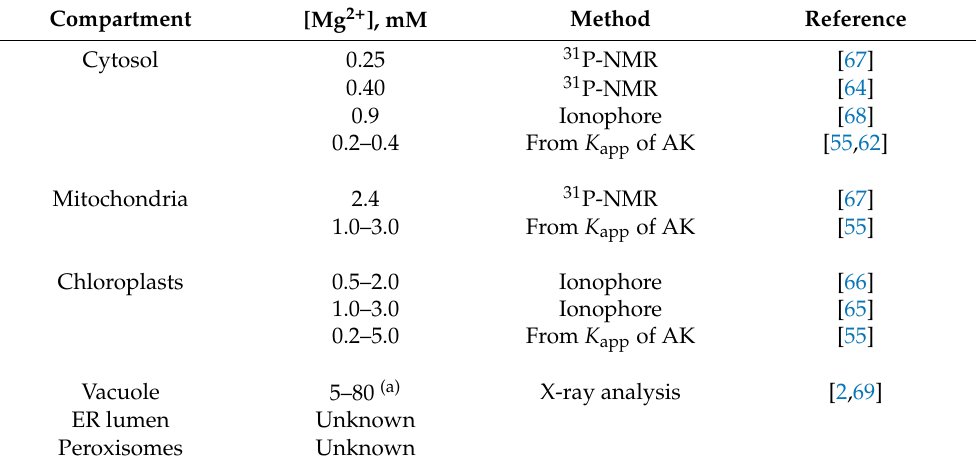
Table 2. [Mg 2+ ] in cellular compartments and methods used to measure [Mg 2+